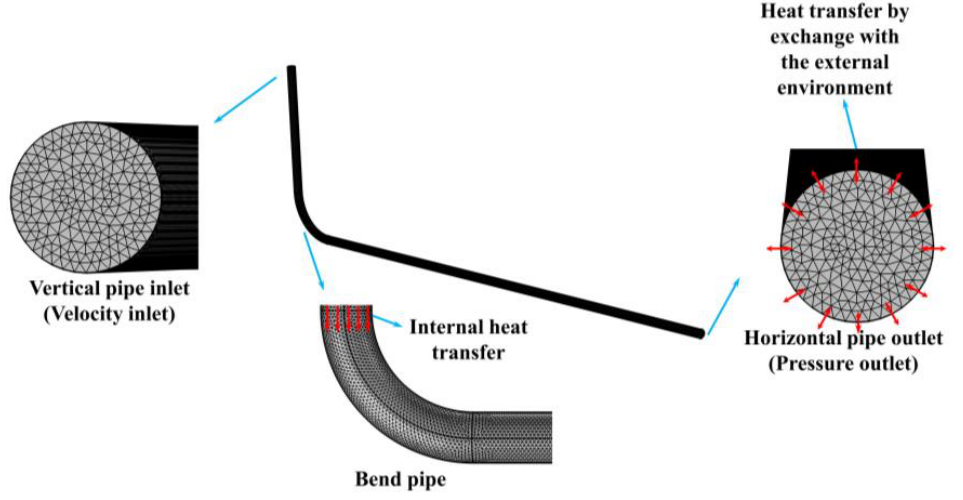
Figure 7. L-pipe transport model of UCPB.